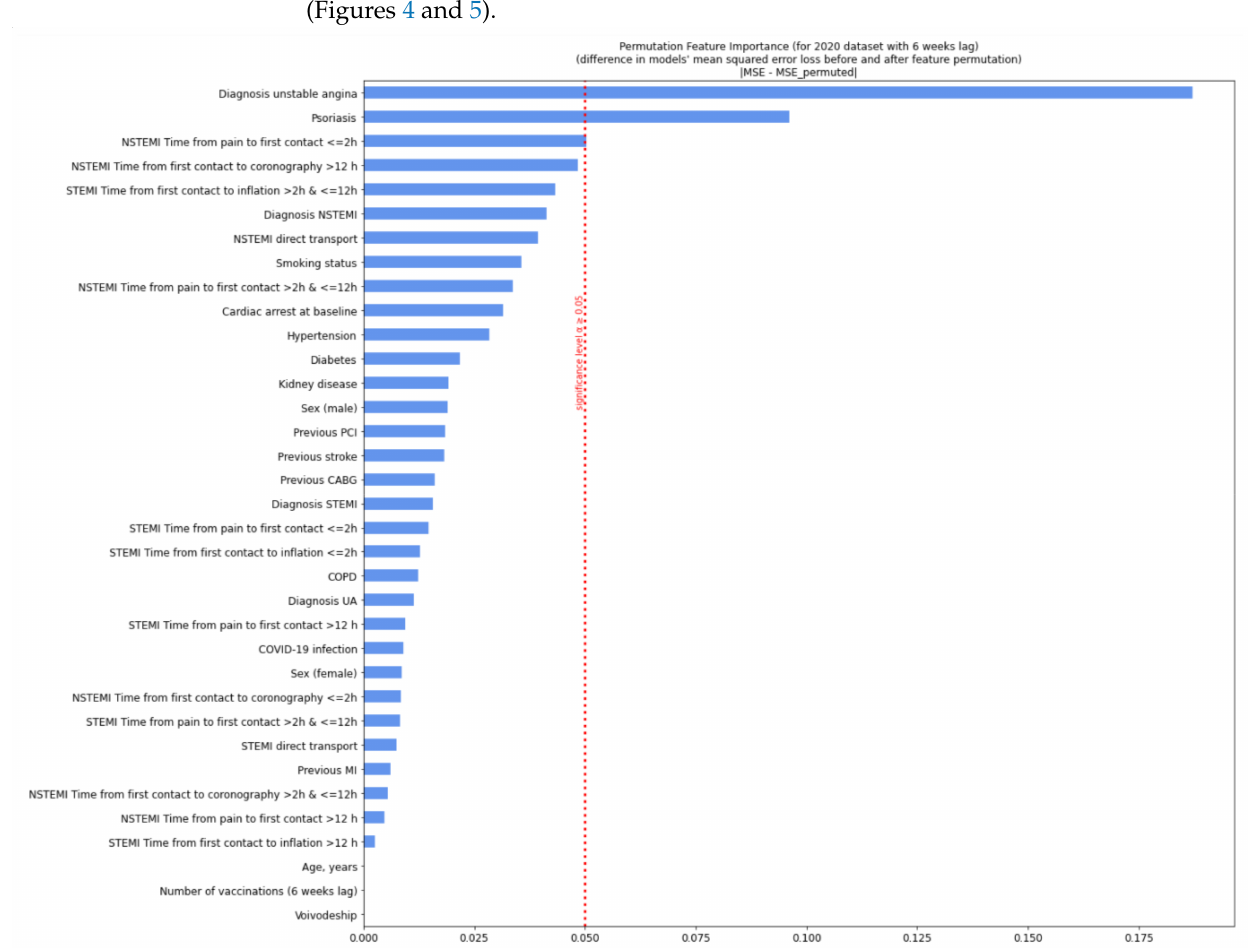
Figure 4. Permutation feature importance analysis for patients in 2020 with a six-week lag. Diagram shows the decrease in the model’s efficiency when values in single individual features are randomly shuffled column-wise and the rest of the features are left unchanged. We measured the neural network efficiency by calculating the mean squared error (MSE) between the target value (true number of deaths during the procedure) and the predicted value (model’s output). The calculation was conducted for each row from data separately and then averaged. In the permutation feature importance, the difference between the MSE error from the neural network, the predicting value from the non-preprocessed dataset, and the MSE error from the neural network, the predicting value from the permuted dataset was measured and showed a decrease on the plot. Variables, when permuted, were affected most in the model’s efficiency decrease and exceeded the